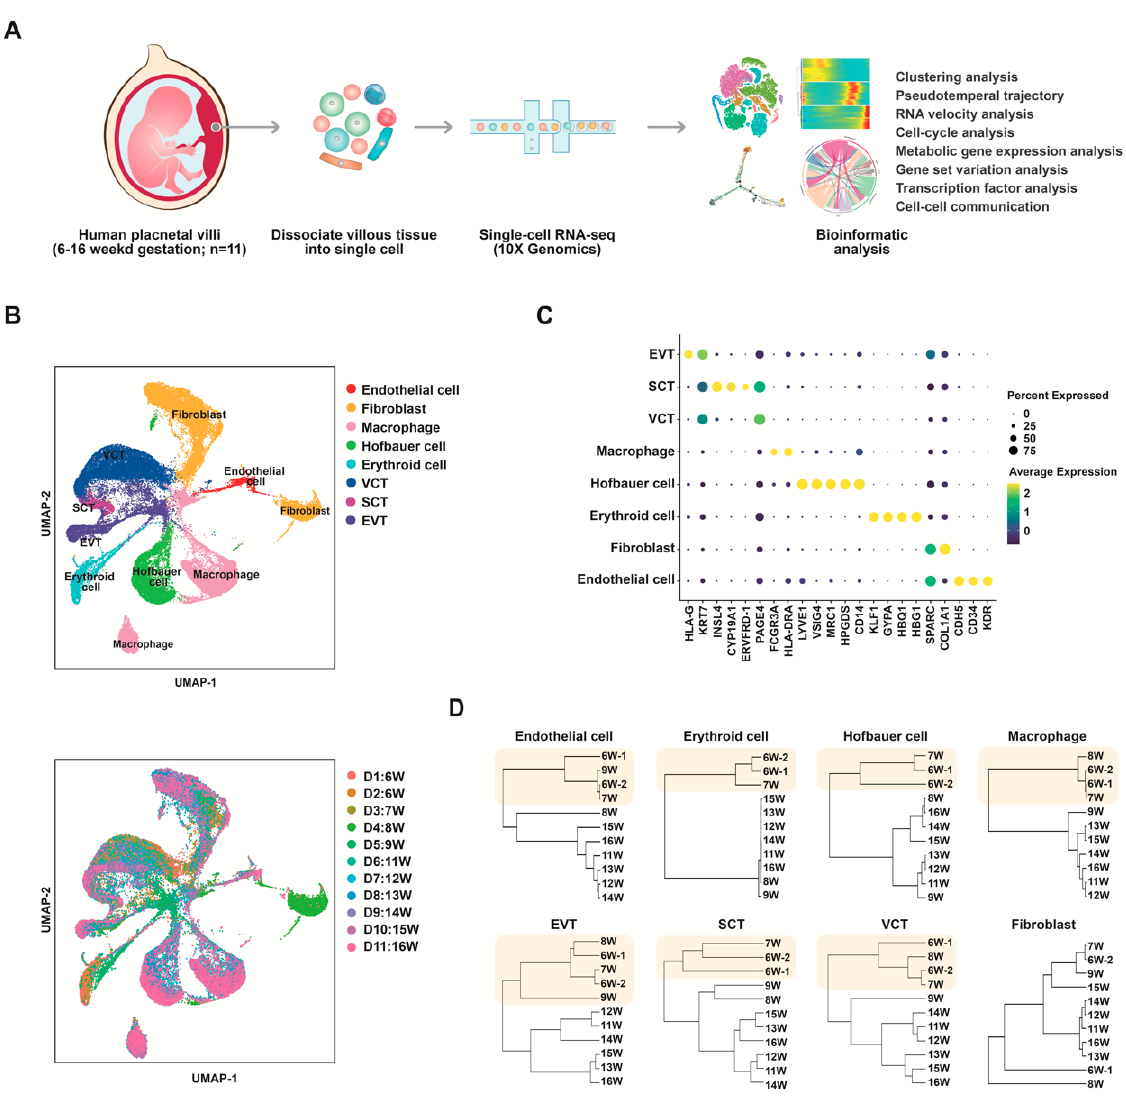
Figure 1. Single-cell RNA-seq of human placenta samples at 6–16 weeks of gestational age. ( A ) Overview of the experimental workflow. ( B ) UMAP plots of cells from human placenta samples, colored by cell type (top) and tissue origin (bottom). ( C ) Dot plot showing the selected marker genes in all cell types. ( D ) Dendrogram visualization of unsupervised hierarchical clustering analysis of expression phenotypes showing the relationships of cells sampled at different gestational ages.